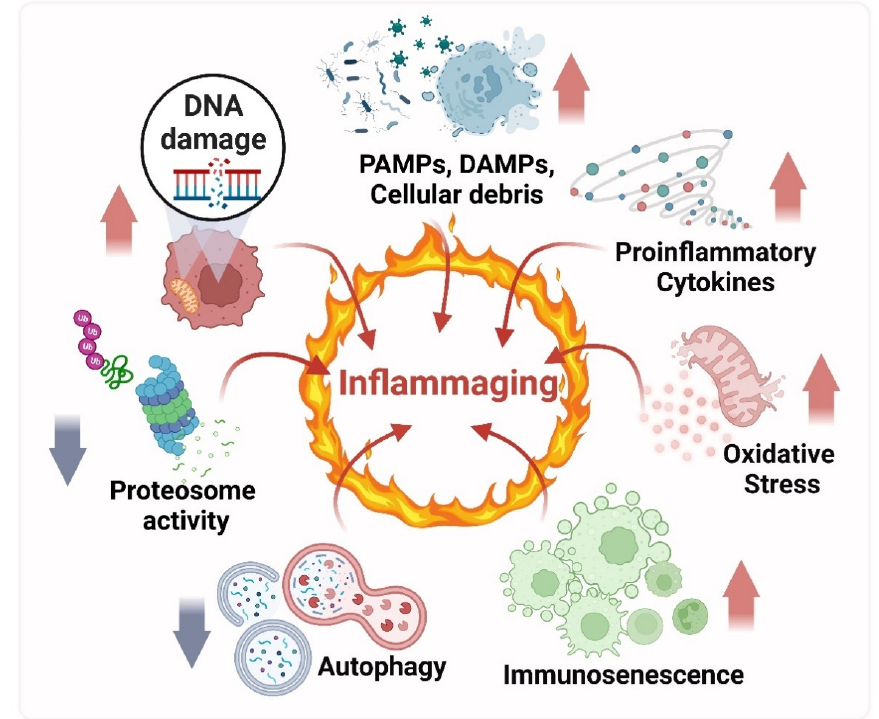
Figure 1. Mechanism of Inflammaging. The mechanisms that generate a progressive increase in the inflammatory state in the organism include the increase in the release of proinflammatory cytokines, the accumulation of oxidation products due to the increase in Reactive Oxygen Species (ROS), de- fects in the autophagy, and proteasome activity; both processes diminished. It is also generated by increased DNA damage in the nucleus and mitochondria, which produces cellular responses related to the induction of senescence in various tissues, including the immune system cells, called im- munosenescence. The immunosenescence reduces the recognition and elimination of Pathogens- Associated Molecular Patterns (PAMPs), Damage-Associated Molecular Patterns (DAMPs), and cel- lular debris by phagocytic cells such as macrophages, and this induces an accumulation that also triggers Inflammaging.